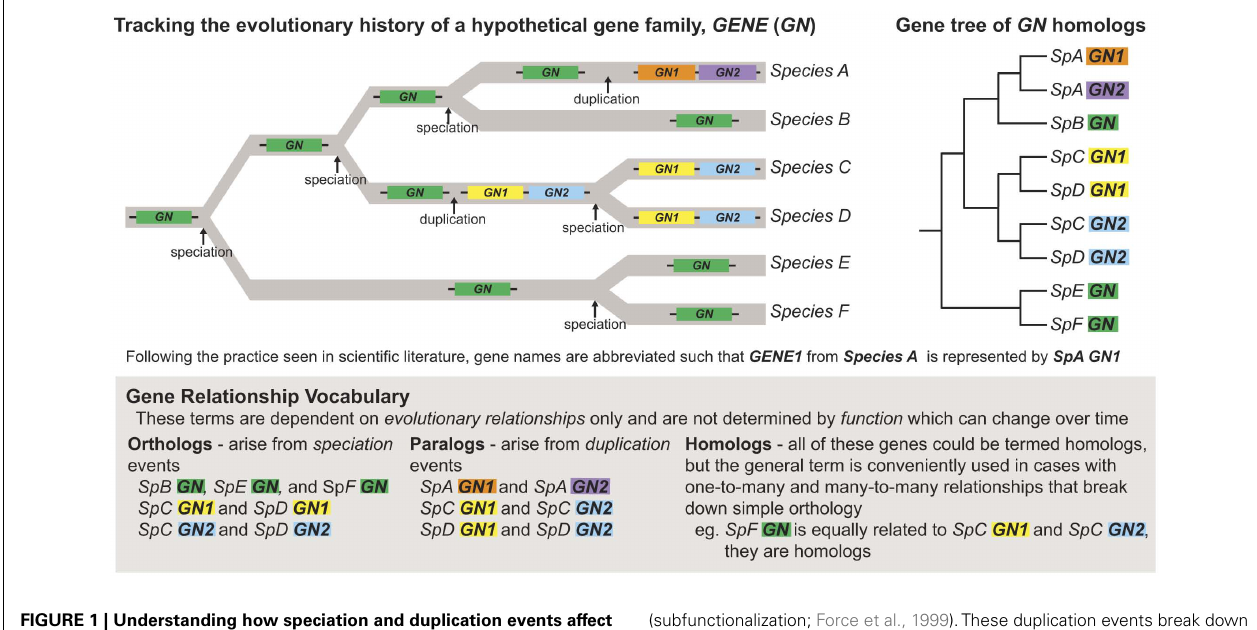
FIGURE 1 | Understanding how speciation and duplication events affect gene orthology, paralogy, and homology. Gene duplication events are commonly recognized as an important mechanism for generating evolutionary novelty (Ohno, 1970). Following a duplication event, a gene pair may diverge in function, with one paralog evolving a new function (neofunctionalization), or with paralogs dividing the function of the ancestral gene between them